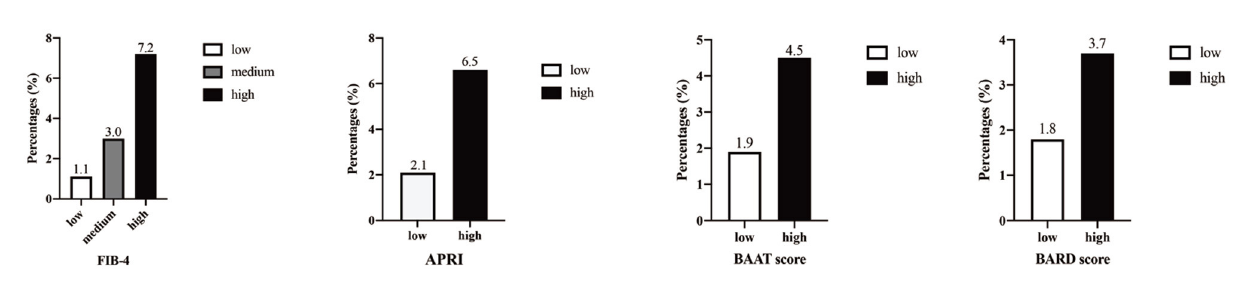
Integrated Discrimination Improvement (IDI). For all analyses, two- tailed P -values of < 0.05 were considered statistically